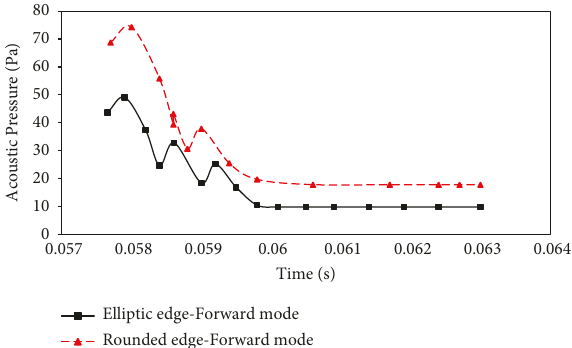
Figure 16: CFD results of the acoustic pressure vs. time at the receiver for the panhead with elliptic edge and rounded edge cross-section at a train speed of 250km/h.